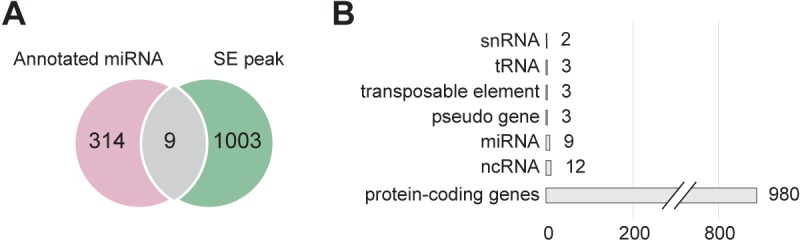
SE mainly binds to protein-coding genes.(A) Venn diagram showing the overlap between SE-ChIP targets and annotated MIRNA genes. (B) Classification of SE target genes in protein-coding genes and various non-coding genes.